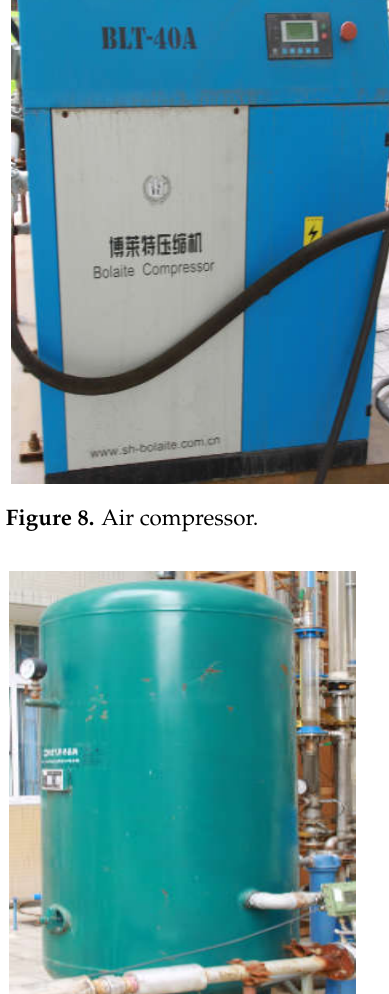
Figure 7. Vertical pipe transport system.